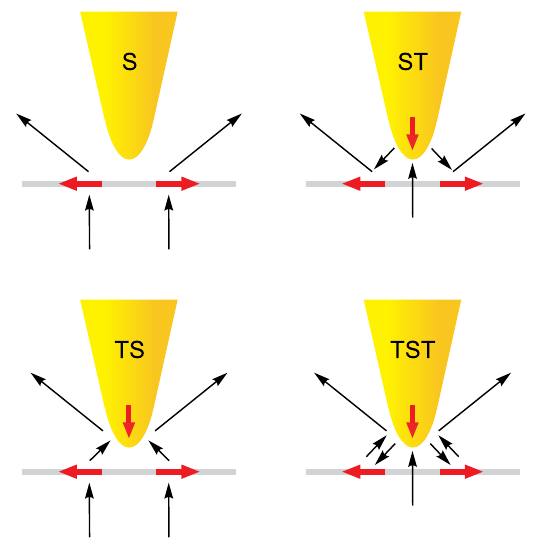
FIG. 3. Interaction series in TERS. Red arrows represent induced dipoles; black arrows indicate electromagnetic